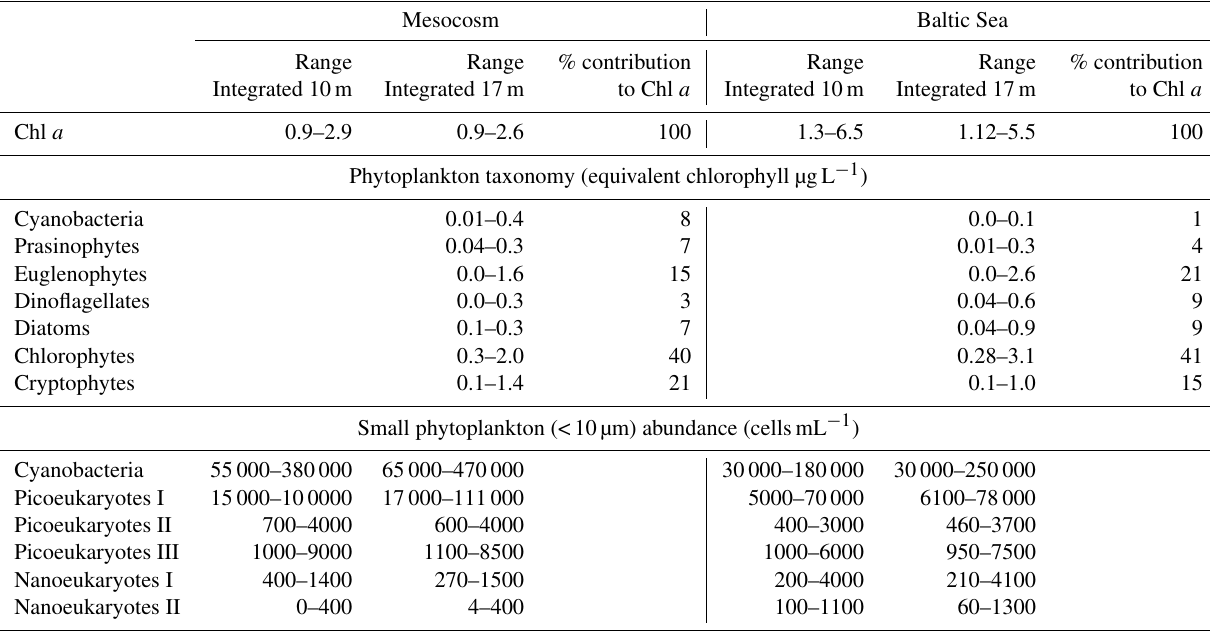
Table 3. Abundance and contributions of different phytoplankton groups to the total phytoplankton community assemblage, showing the range of measurements from total Chl a (Paul et al., 2015), CHEMTAX analysis of derived Chl a (Paul et al., 2015), and phytoplankton abundance (Crawfurd et al., 2016). Data are split into the range of all the mesocosm measurements and those from the Baltic Sea.